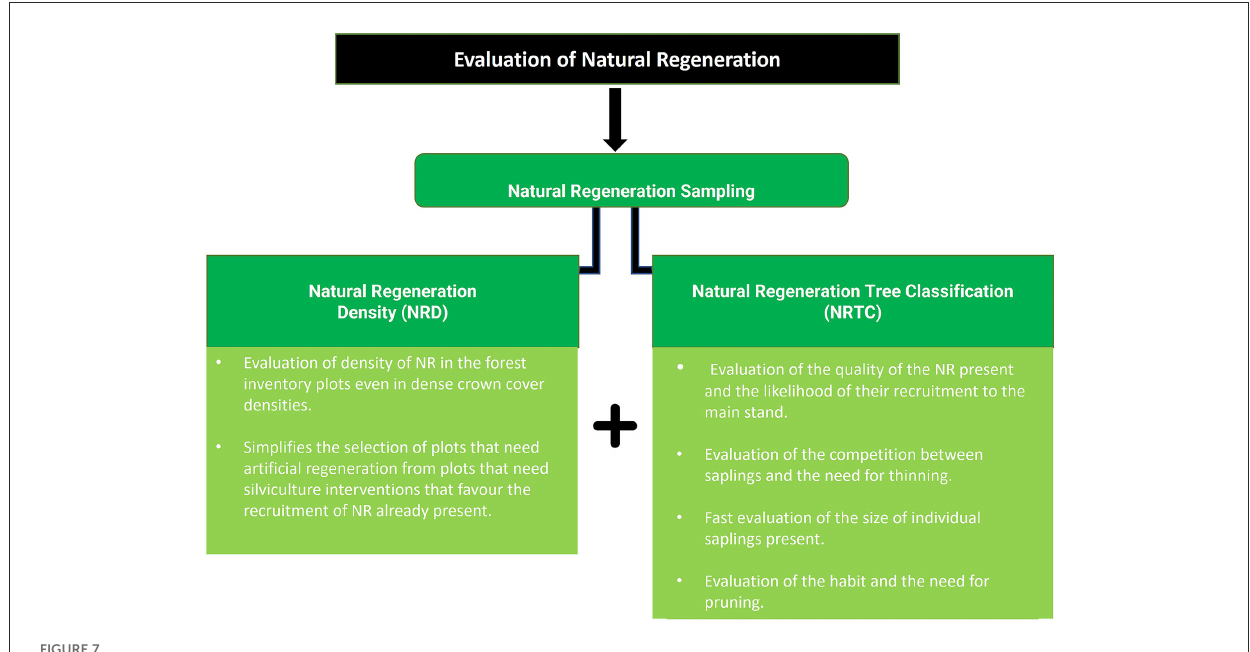
FIGURE7 Evaluation of natural